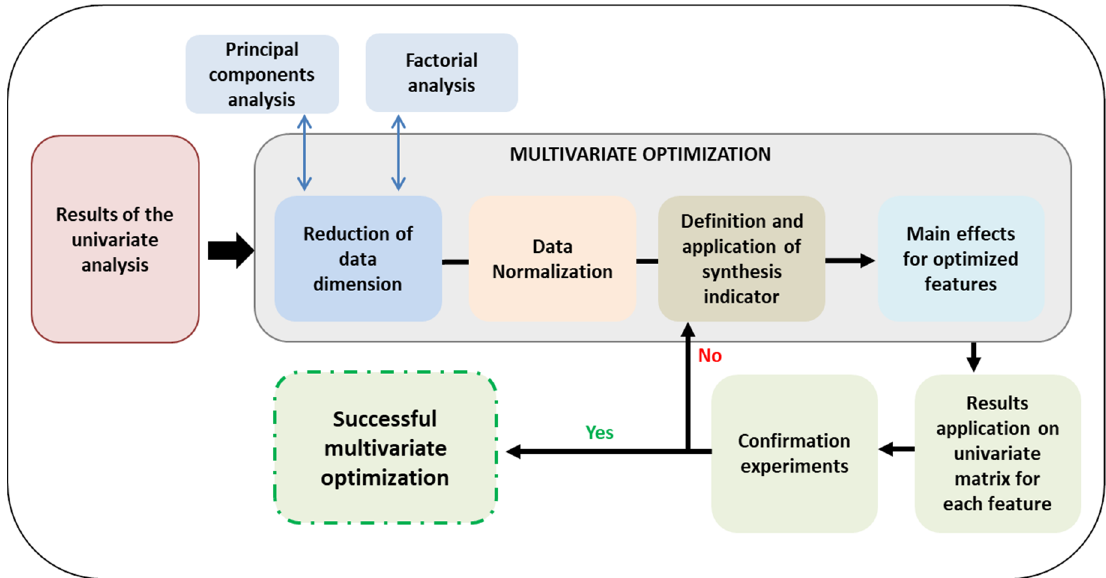
Figure 11. Multivariate optimization workflow used in this study.